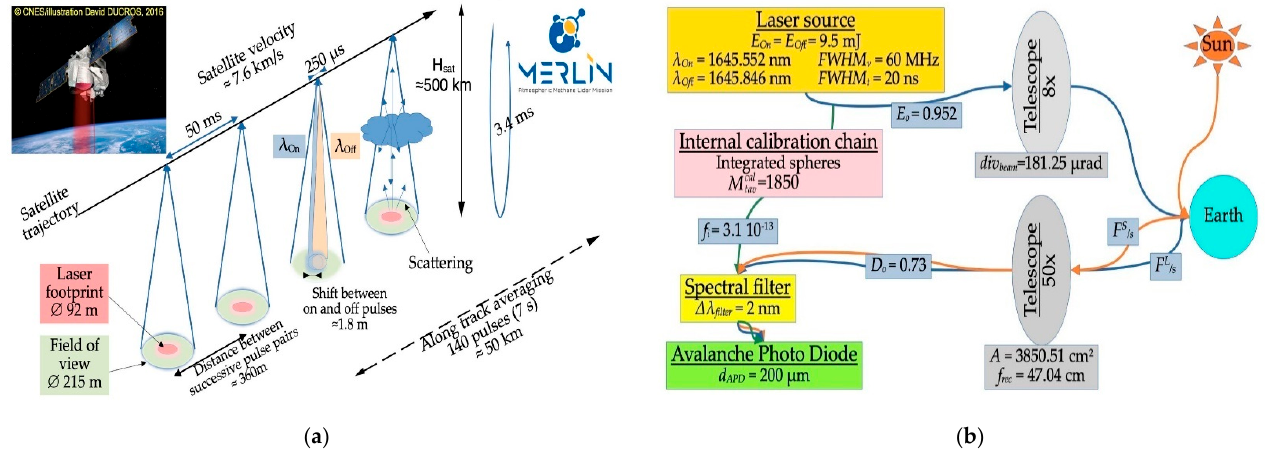
Figure 1. ( a ) Principle of the satellite-based IPDA lidar technique applied to MERLIN; ( b ) Optical flow diagram for MERLIN (for the meaning of the variables see the text). Table 2. User requirements for MERLIN.